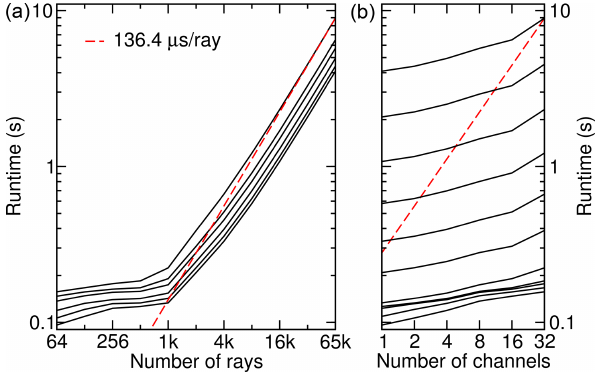
Figure 13. Scaling of the (REF) reference implementation runtime with the number of ray paths and channels. In contrast to Fig. 12, only up to 4k ray paths have been benchmarked, and the linear slope extrapolates to 65k for eight channels (black dot) since that config- uration reached the best